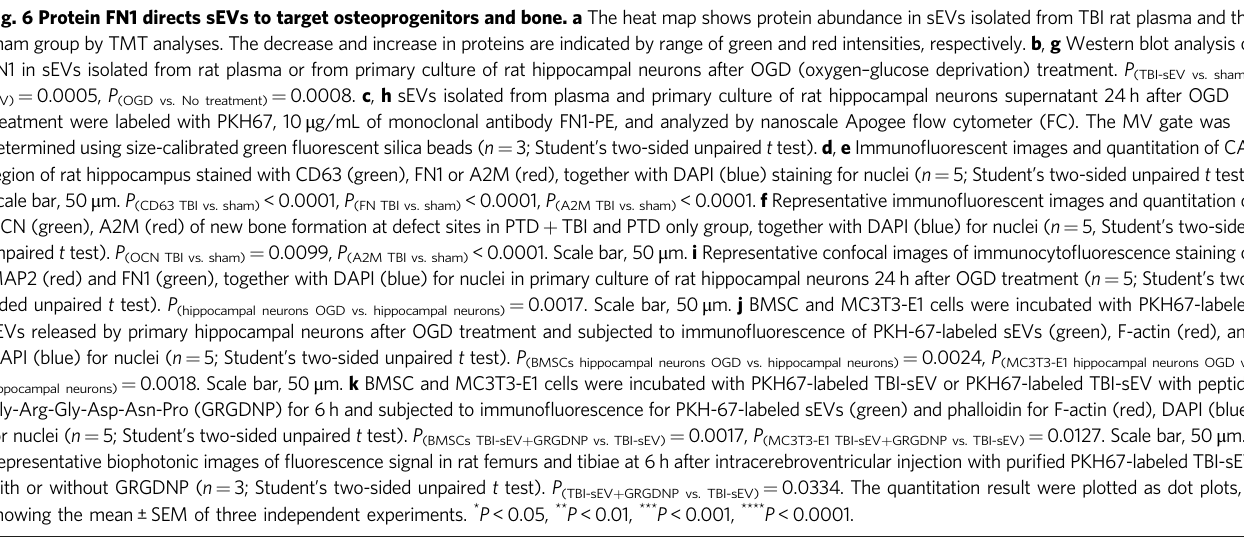
Representative biophotonic images of fl uorescence signal in rat femurs and tibiae at 6h after intracerebroventricular injection with puri fi ed PKH67-labeled TBI-sEV with or without GRGDNP ( n = 3; Student ’ s two-sided unpaired t test). P (TBI-sEV + GRGDNP vs. TBI-sEV) = 0.0334. The quantitation result were plotted as dot